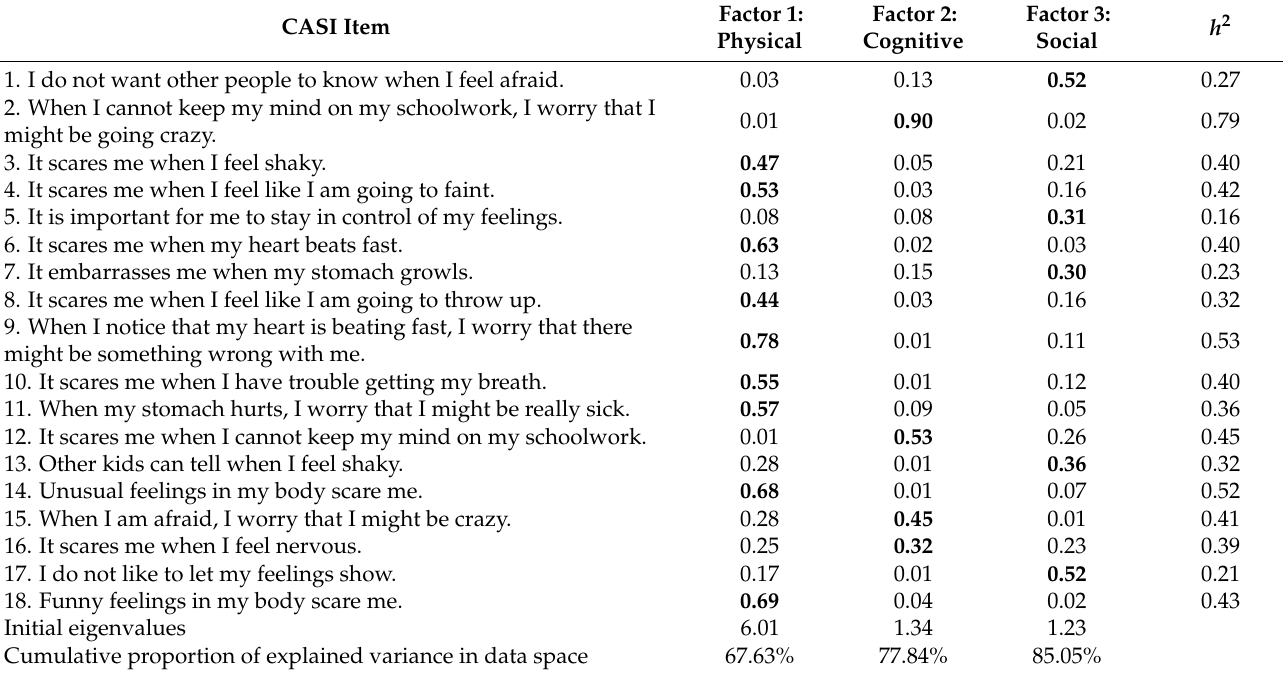
Cumulative proportion of explained variance in data space